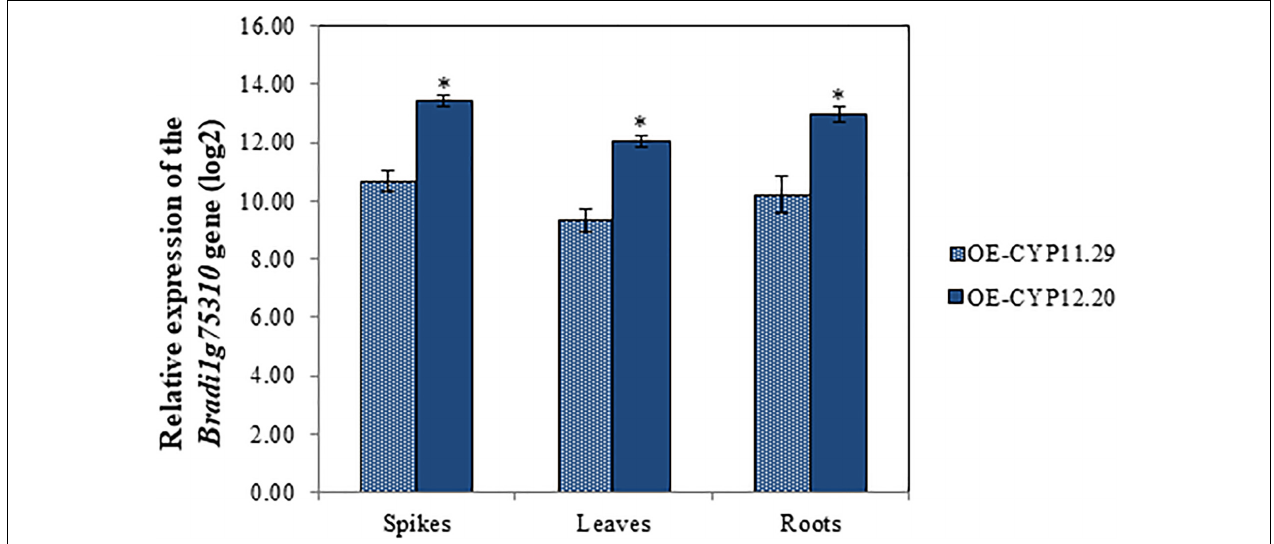
FIGURE 4 | Molecular characterization of B. distachyon lines overexpressing the BdCYP711A29 gene. Relative expression of the BdCYP711A29 gene in spikes. leaves and roots of overexpressing lines OE-CYP11.29 and OE-CYP12.20. The relative quantity of BdCYP711A29 transcripts (fold-change. log 2 ) of OE lines as compared with the Bd21-3 WT line was calculated using the comparative cycle threshold method (2 - (cid:49)(cid:49) Ct ). The B. distachyon UBC18 and ACT7 genes ( Bradi4g00660 and Bradi4g41850 ) were used as endogenous controls to normalize the data for differences in input RNA between the different samples. Data represent mean values of three independent biological experiments ( n = 3) and two technical repetitions ± standard deviation. Different letters indicate significant differences between conditions (Student’s t- test p value <